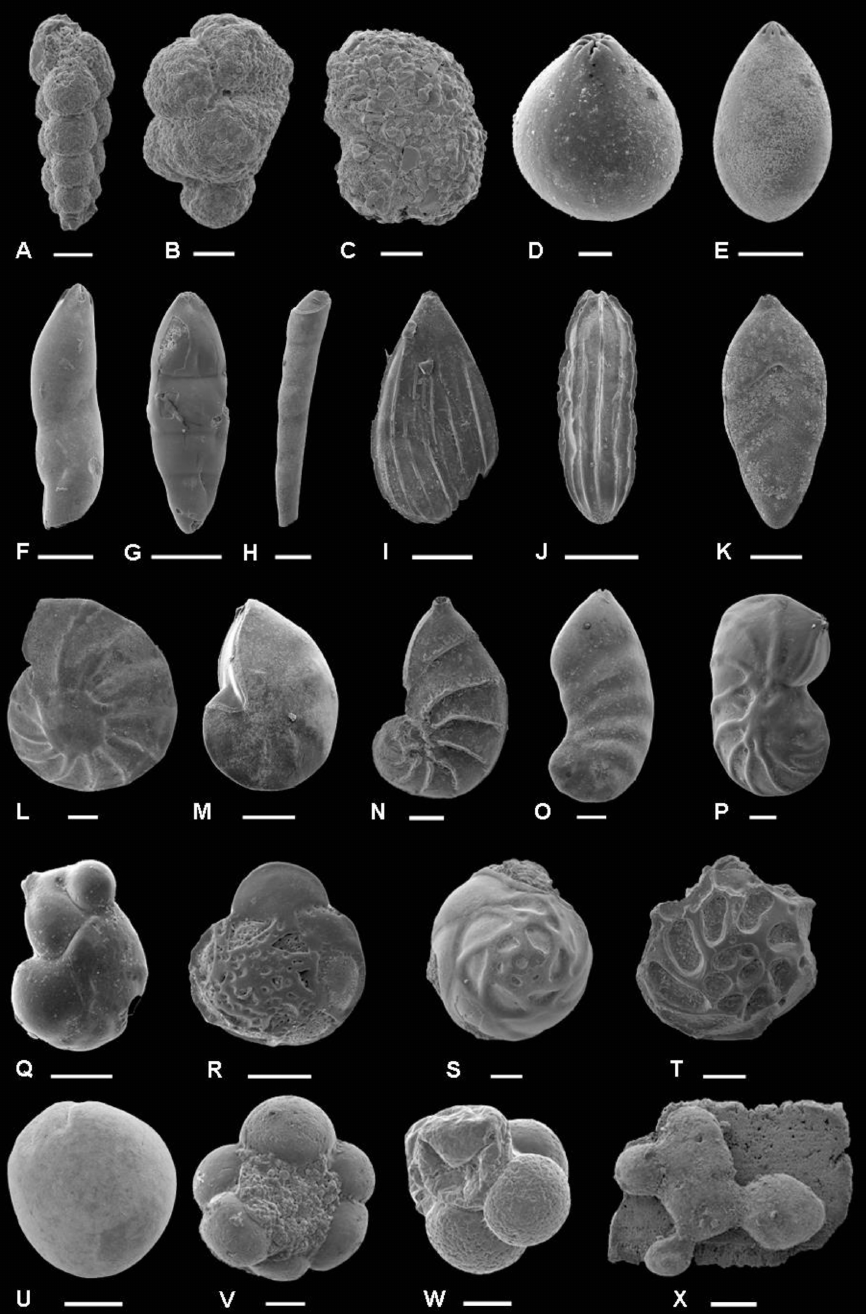
Figure 3. Illustration of some of the foraminifera recovered in the samples from Core 10: (a) Verneuilinoides tryphera (scale bar 50µm); (b) Verneuilinoides sp. 2 Morris and Coleman, 1989 (scale bar 50µm); (c) Trochammina sp. (scale bar 100µm); (d) Oolina sp. (scale bar 20µm); (e) Oolina sp. (scale bar 100µm); (f) Eoguttulina liassica (scale bar 100µm); (g) Frondicularia irregularis (scale bar 100µm); (h) Dentalina pseudocommunis (scale bar 100µm); (i) Citharina flabellata (scale bar 100µm); (j) Nodosaria hortensis (scale bar 100µm); (k) Frondicularia franconica (scale bar 100µm); (l) Lenticulina muensteri (scale bar 100µm); (m) L. muensteri with no umbilical boss (scale bar 100µm); (n) L. muensteri showing uncoiling (scale bar 100µm); (o) Lenticulina sp., showing distinct uncoiling and thickened sutures (scale bar 100µm); (p) L. muensteri , showing test deformation (scale bar 100µm); (q) Lenticulina sp., showing chamber deformation and, what appears to be an additional chamber (scale bar 100µm); (r, s) Epistomina regularis (scale bar 100µm); (t) Epistomina stellicostata Bielecka and Pozaryski (scale bar 100µm); (u) Reinholdella lutzei (scale bar 100µm); (v, w) Conoglobigerina sp., an example of a pyrite steinkern of a planktic foraminiferid (scale bar 50µm); (x) Bullopora sp. adherent on shell fragment (scale bar 200µm). Reproduced from Hart et al. (2016a) with